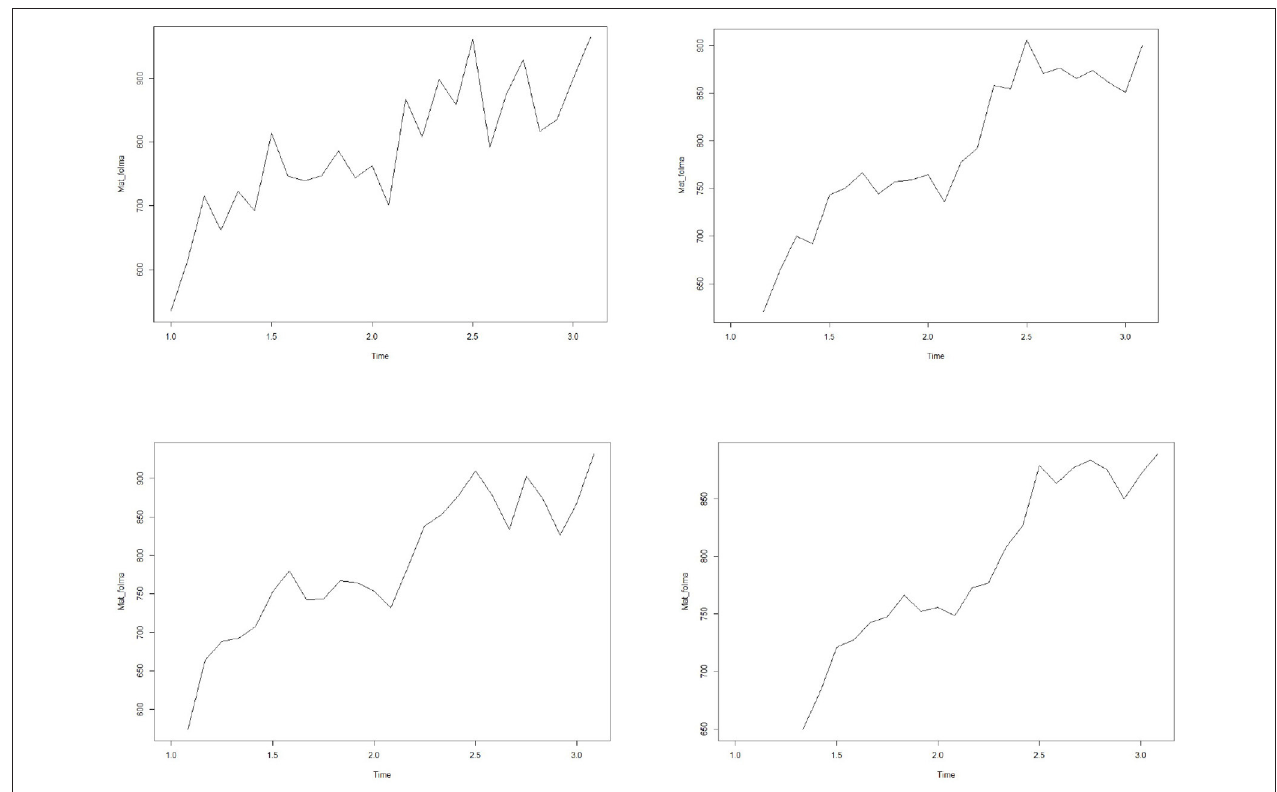
FIGURE 1 | Smoothed time series of patient flow.